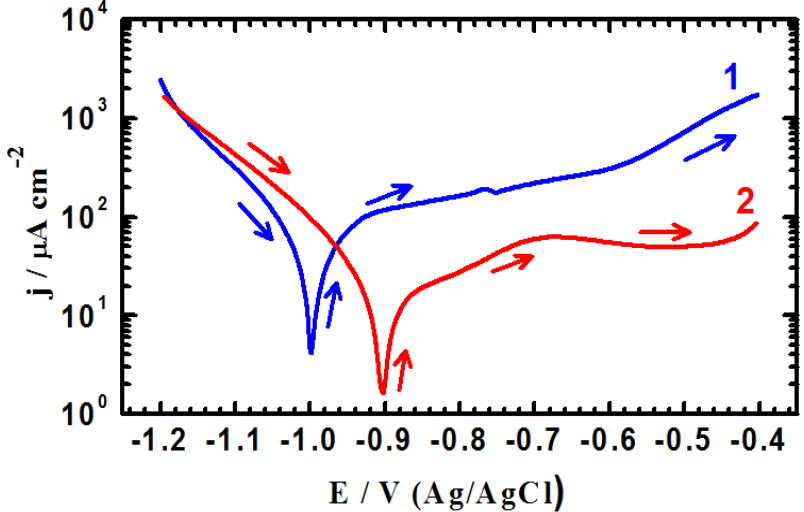
Figure 2. Potentiodynamic polarization curves for (1) pure iron and (2) API X-65 steel after their immersion for 12 h in 4.0 wt % NaCl solutions.